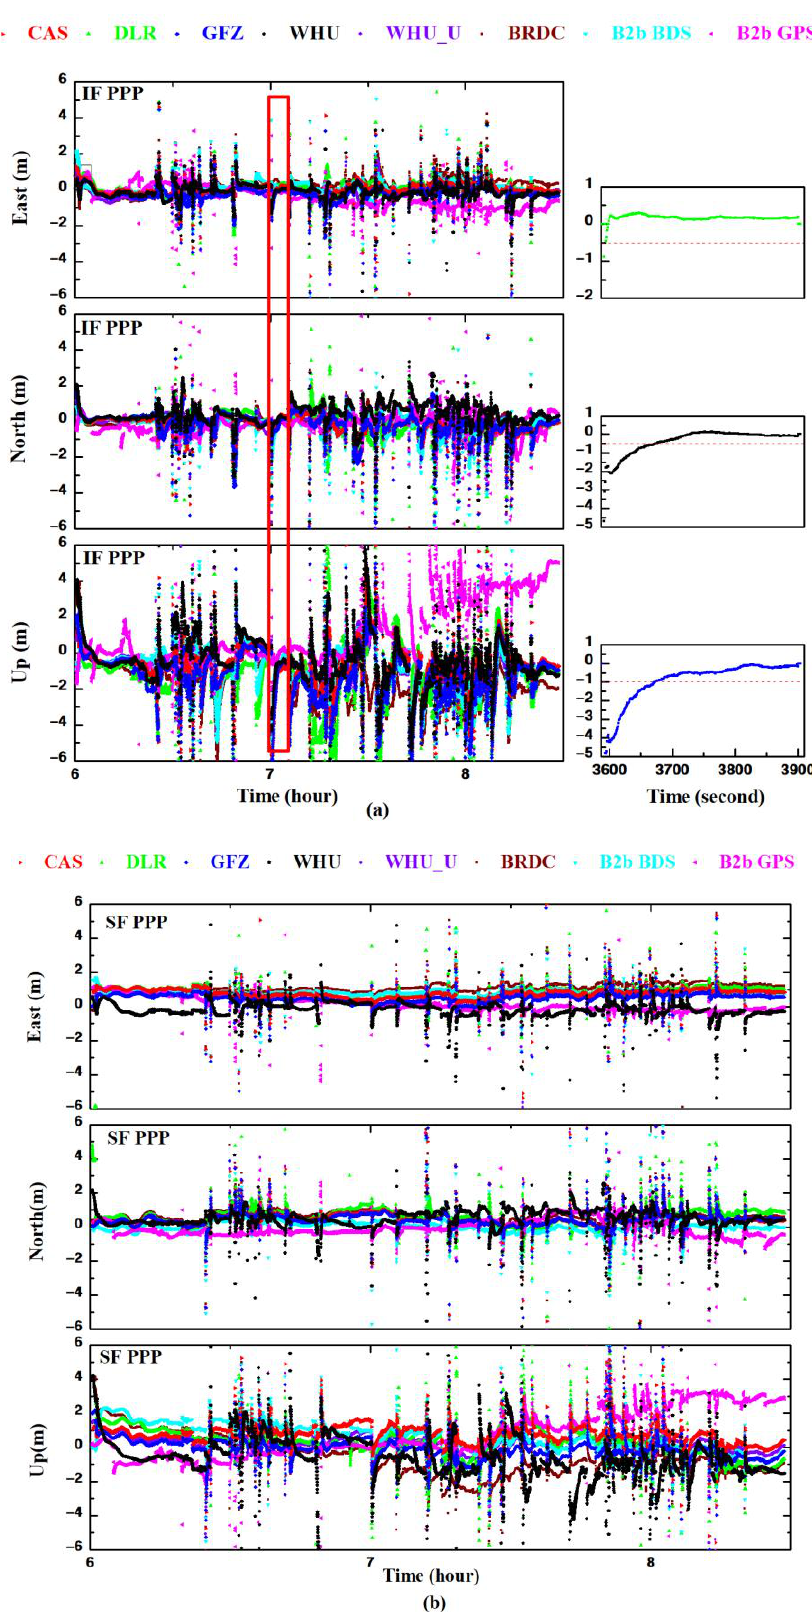
Figure 14. Time series of position errors of the dual-( a )/single ( b )-frequency vehicle-borne RT-PPP using different SSR products.